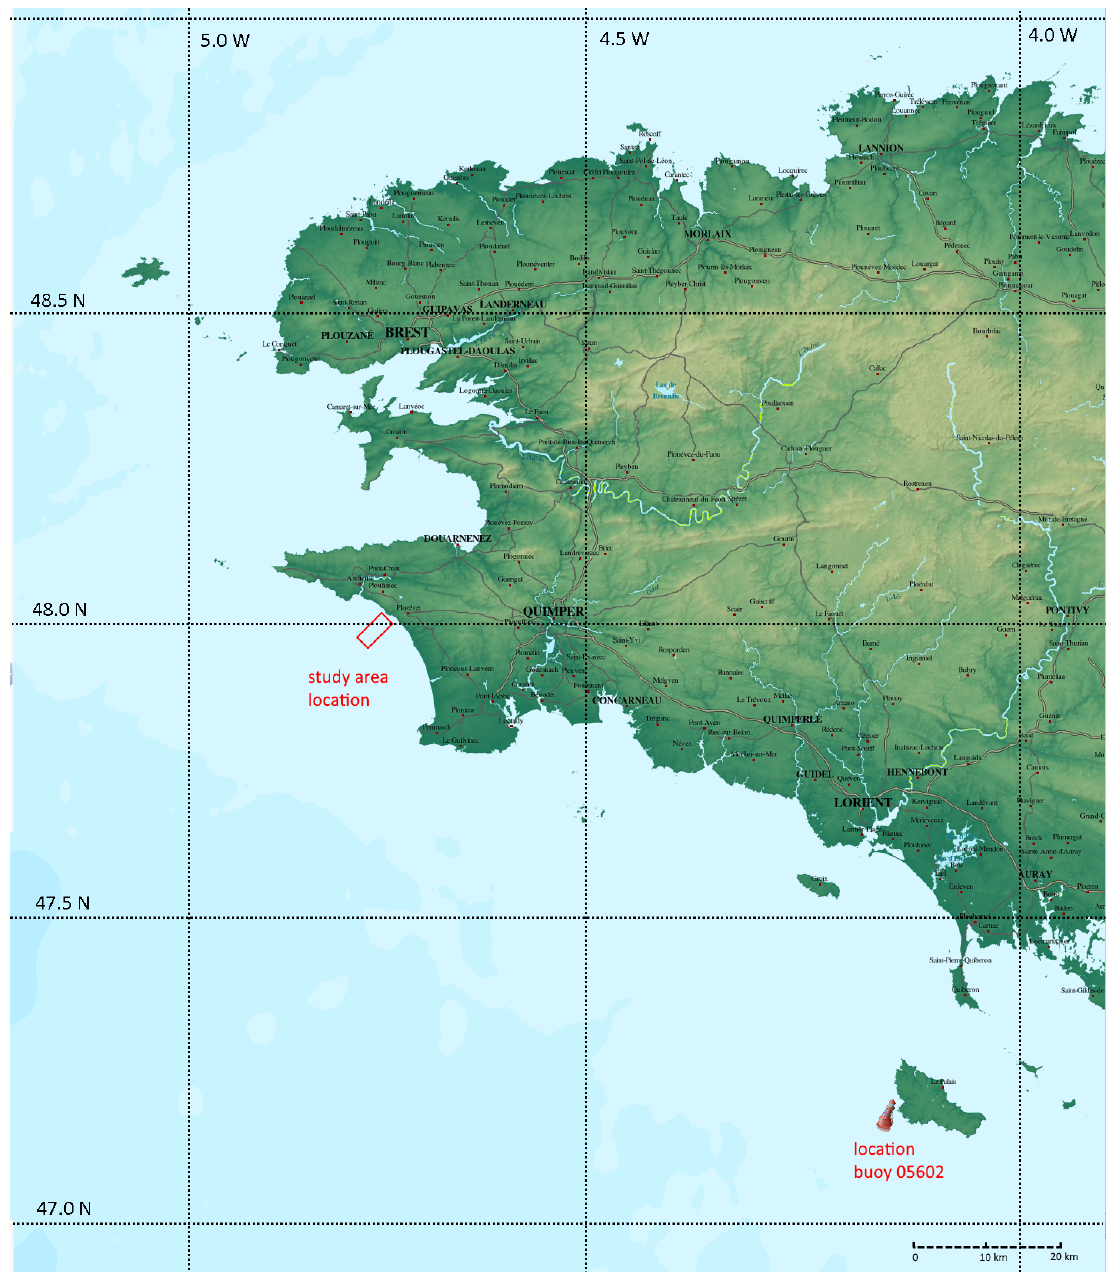
Figure 1. Map locating the investigation domain at the proposed WATTMOR project site in the Baie d’Audierne and the CANDHIS buoy 05605 (Belle-île) which serves as the source of the wave data off the coast of Bretagne,